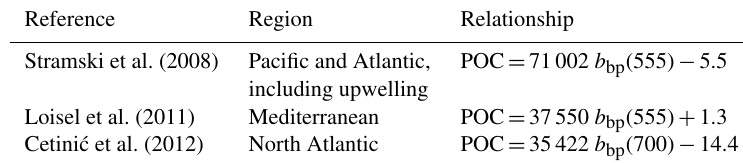
Table 2. POC-to- b bp relationships from the literature (with POC and b bp in units of mgm − 3 and m − 1 ,